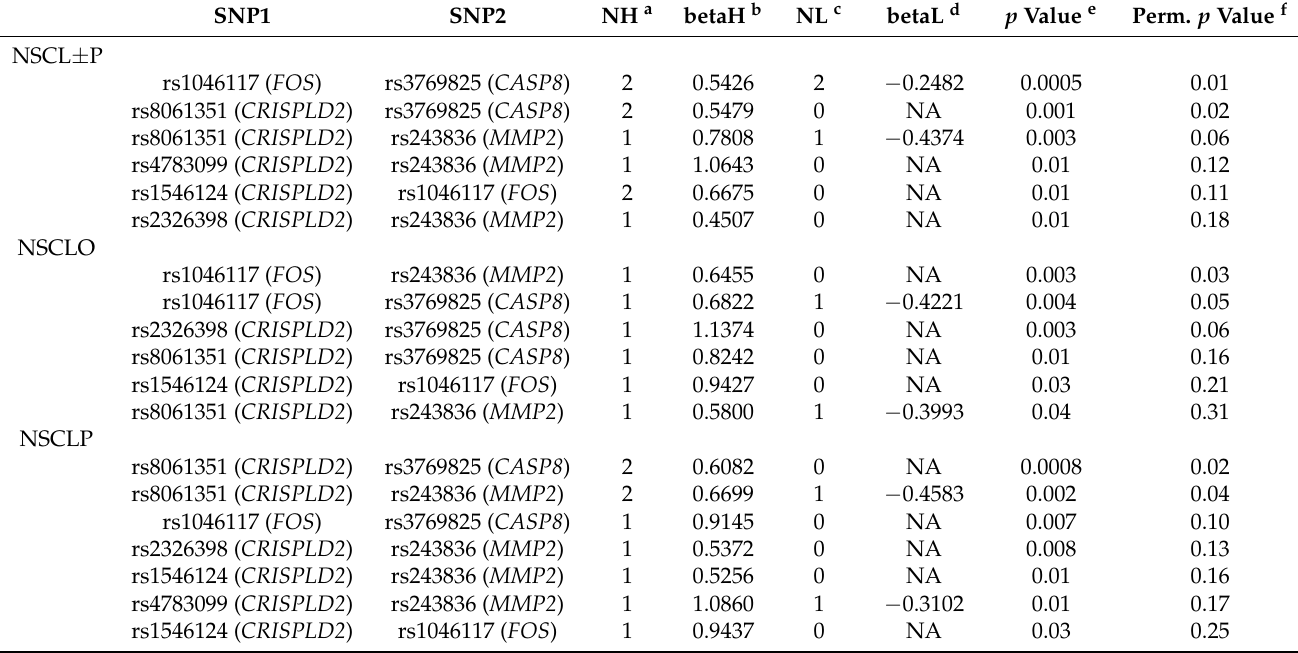
Table 5. SNP-SNP interactions among CRISPLD2 , FOS , CASP8 and MMP2 assessed by the model- based multifactor dimensionality reduction ( mbmdr)